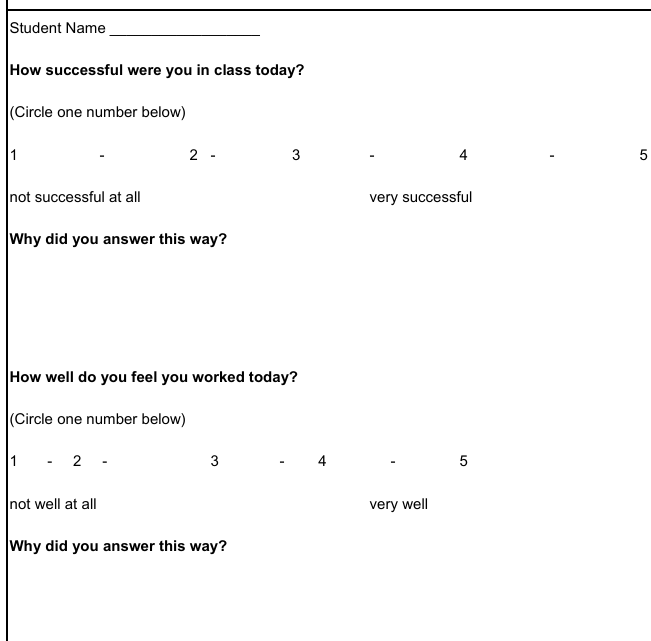
Figure 1: Exit Ticket